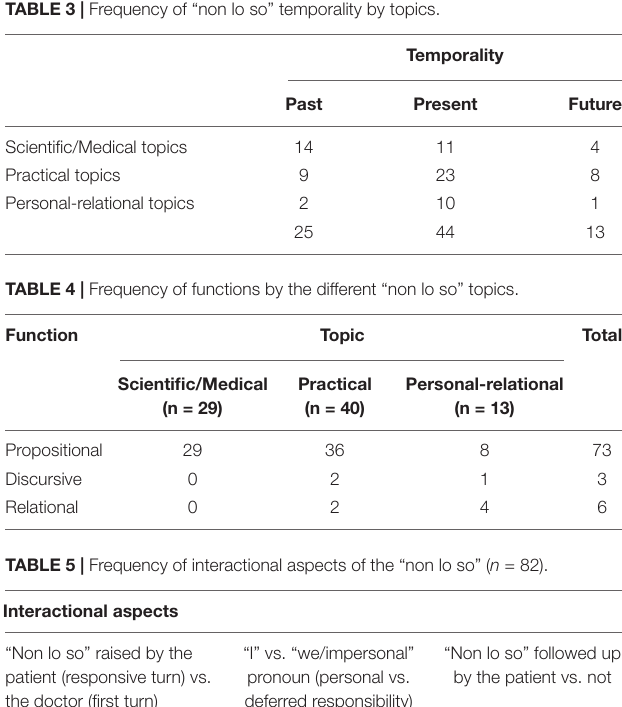
TABLE 3 | Frequency of “non lo so” temporality by topics.